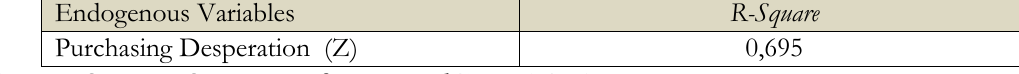
Table. 7 R-Square Test